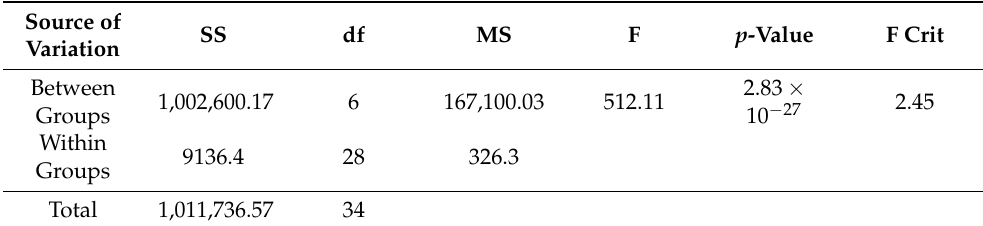
Table 5. Resulting ANOVA for compressive strength of GFRP laminates tested under temperatures of − 80–100 ◦ C.